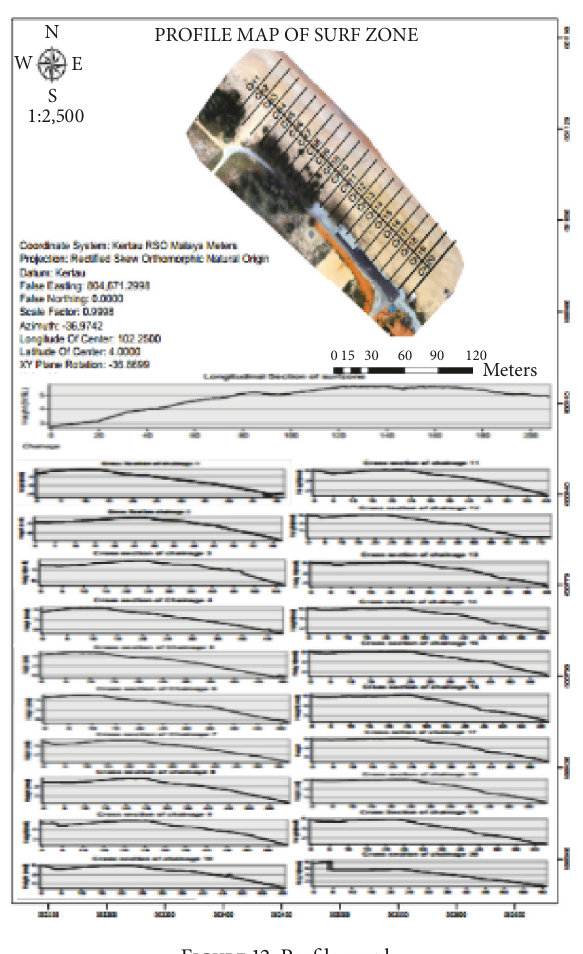
Figure 12: Profile graph. Table 6: The details of cost, time, and labour needed for UAV and conventional methods.